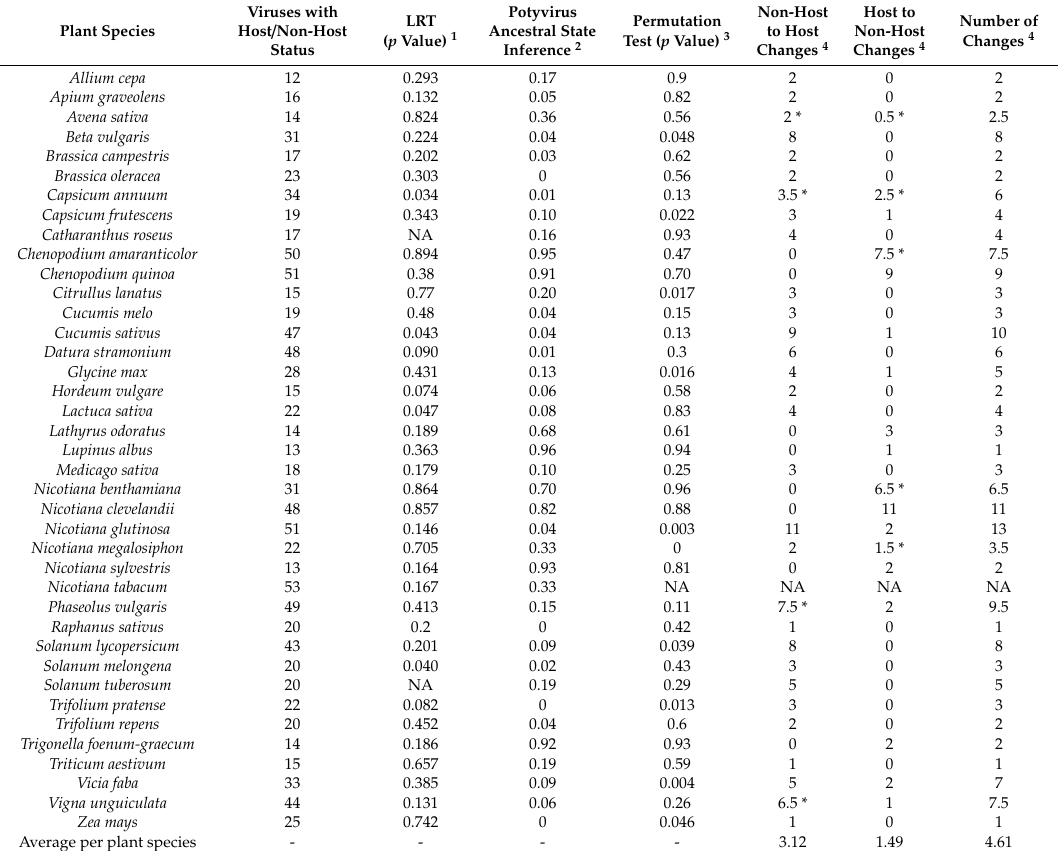
Table 1. Summary results of phylogenetic inference of host range